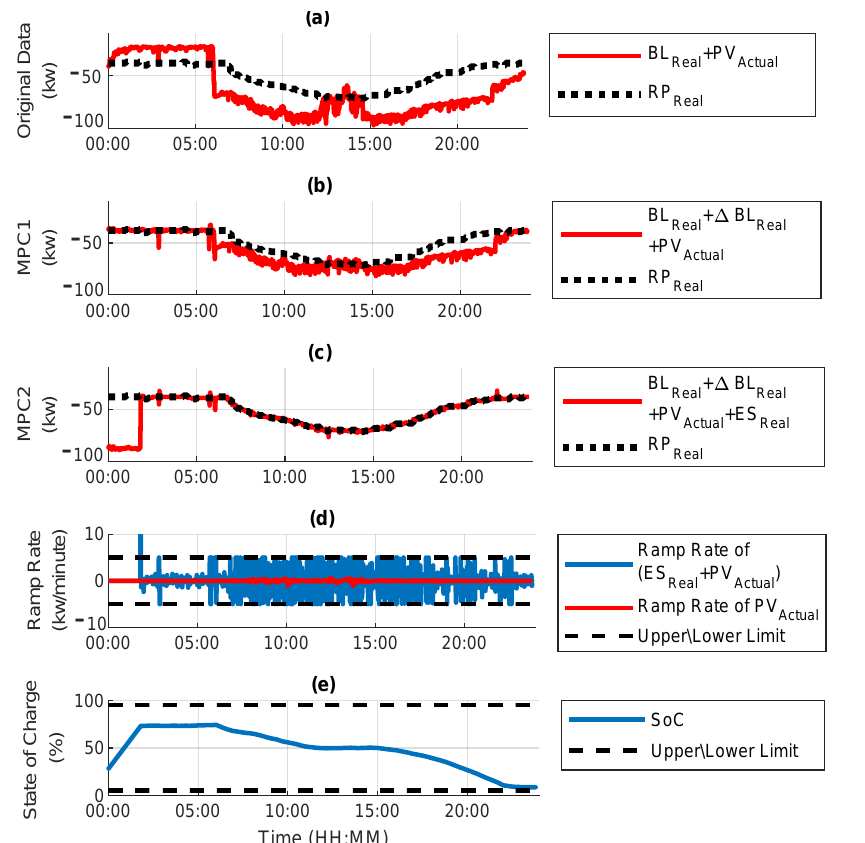
Figure 10. Day 2 real power ( a ) original data, ( b ) MPC1 simulation result, ( c ) MPC2 simulation results, ( d ) ramp rate constraint, and ( e ) energy storage SoC